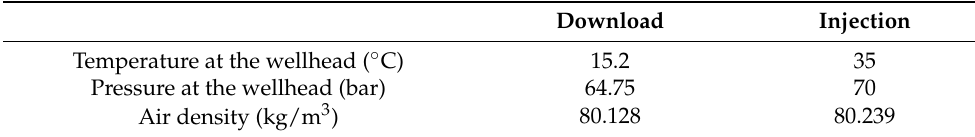
Table 3. Gas (air) parameters adopted in the model.